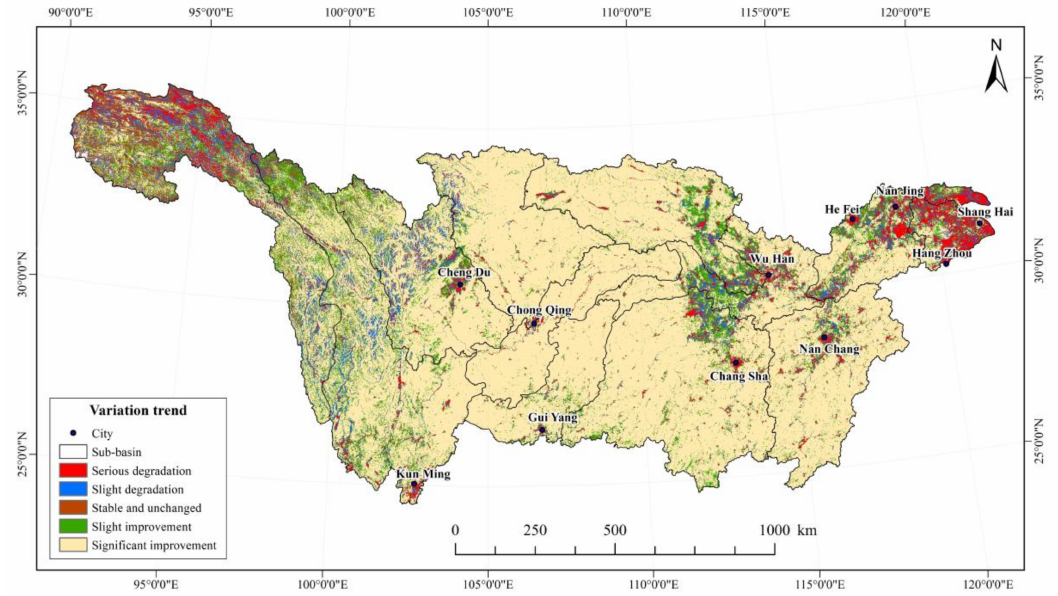
Figure 6. NDVI variation trend in Yangtze River